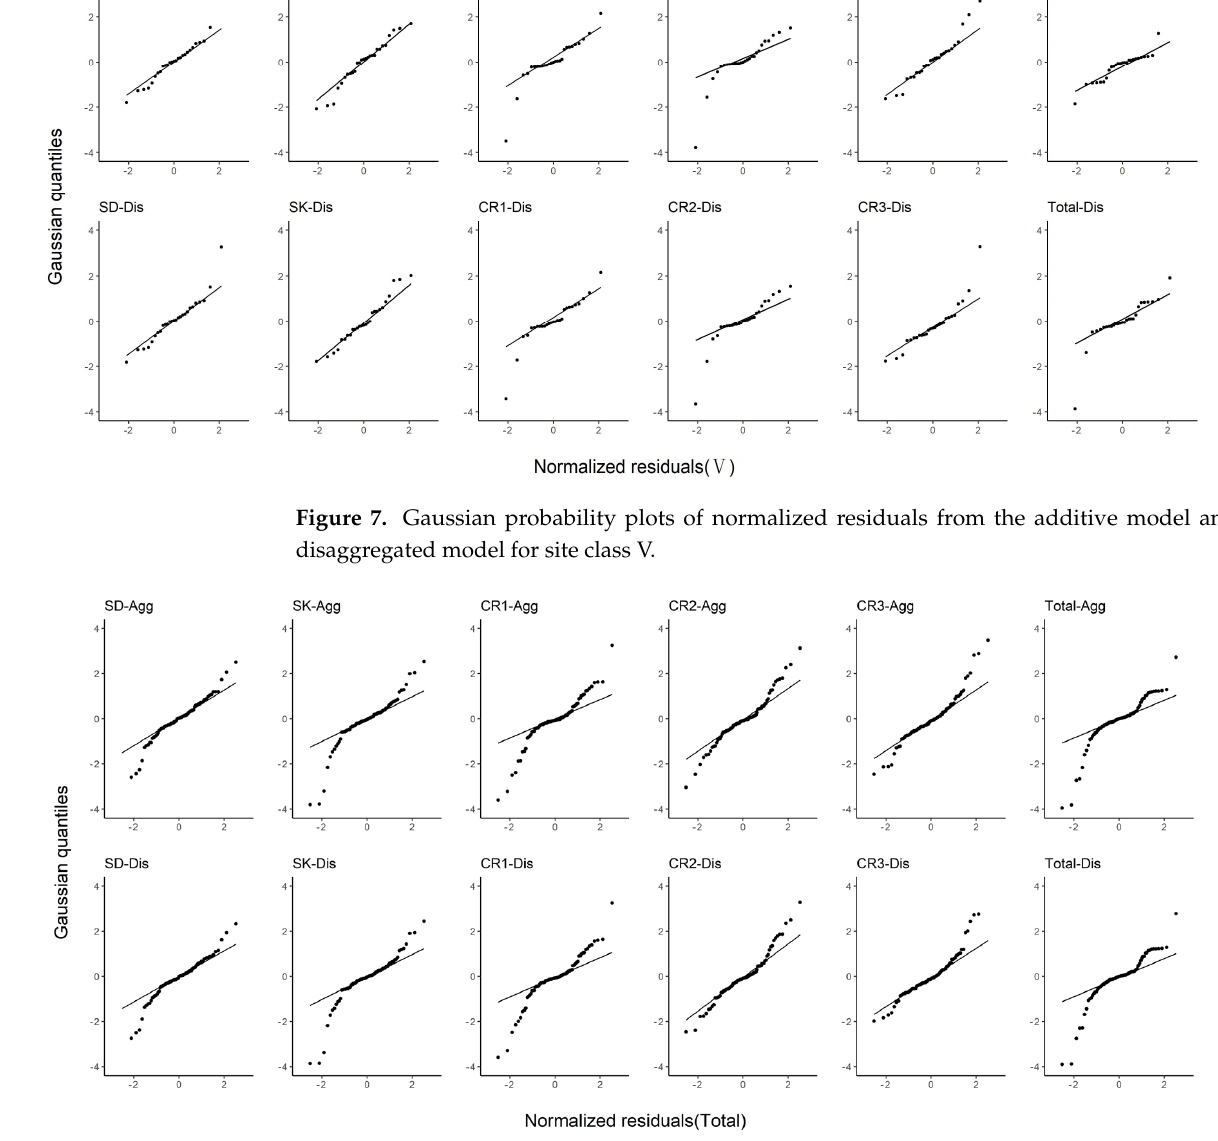
Figure 8. Gaussian probability plots of normalized residuals from the additive model and the disaggregated model for all site classes.